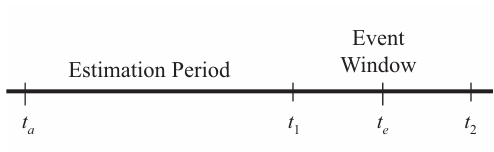
Figure 3. Event study